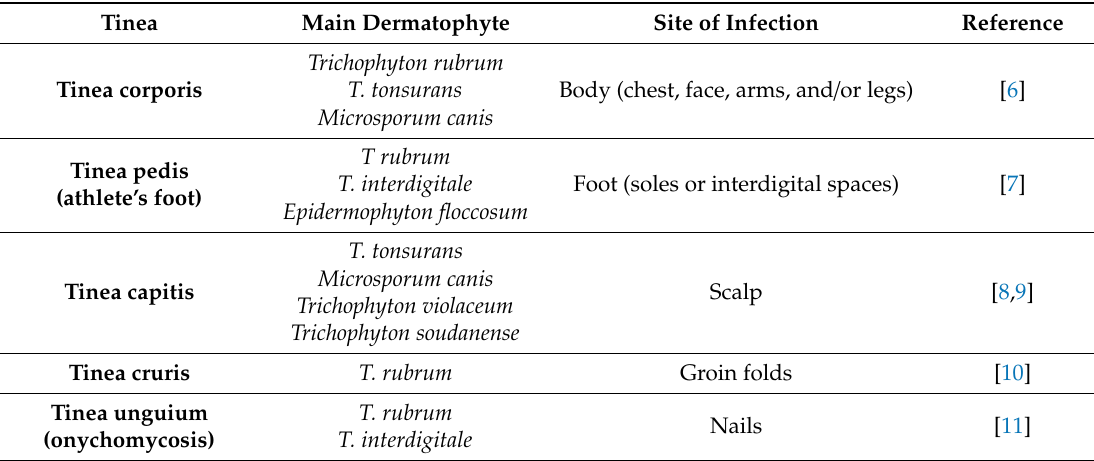
Table 1. Main types of